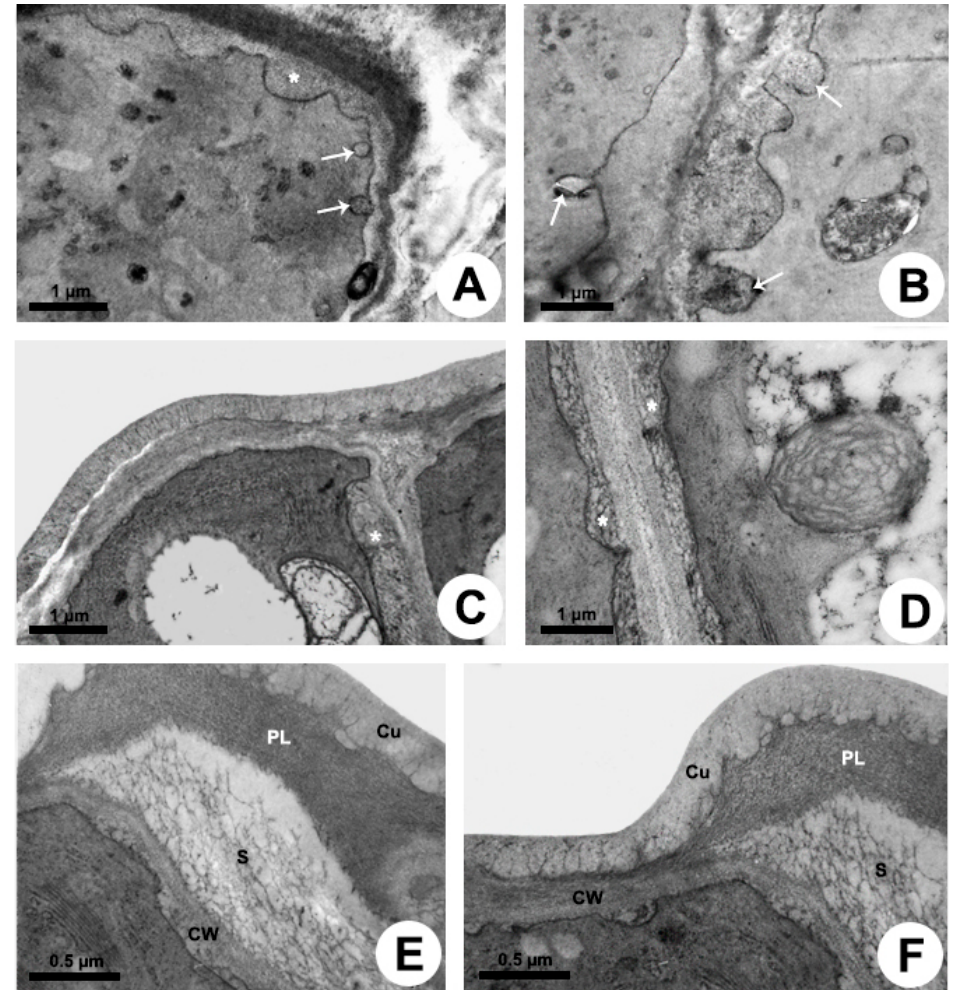
Figure 4. Secretion release in colleters of Peplonia axillaris ( A , B ) and Mandevilla splendens ( C – F ). Transmission electron microscopy. ( A – D ) Fusion of vesicles with plasma membrane and formation of a large periplasmic space. ( E , F ) Intramural space filled with secretion. Arrow = merging vesicle with plasma membrane; Asterisk = periplasmic space with secretion; Cu = cuticle; CW = cell wall; PL = pectin-rich layer; S = secretion.